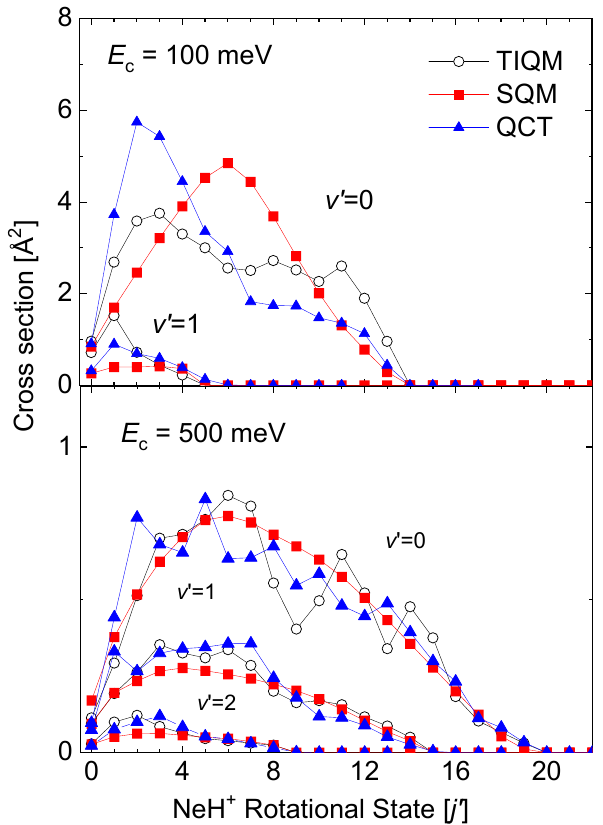
Figure 12. Rotational distributions (in Å 2 ) for the Ne + HeH + ( v = 0, j = 0 ) → He + NeH + ( v (cid:48) , j (cid:48) ) reaction at two different values of the collision energy: 100 meV ( top panel ) and 500 meV ( bottom panel ). TIQM (open black circles), SQM (red squares), and QCT (full blue triangles) cross sections from Ref. [64] are